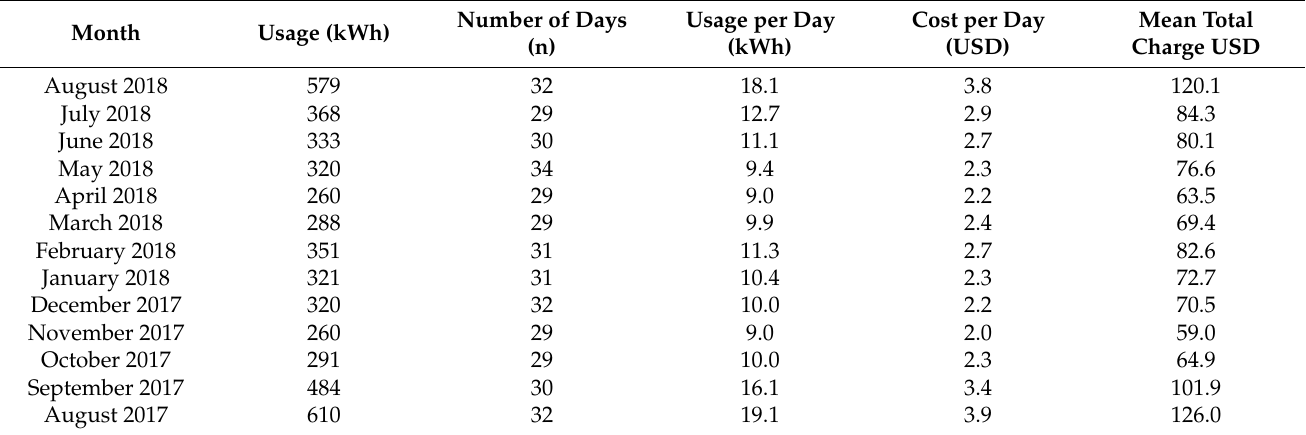
Table 8. Summary of the averages of the monthly electricity usage in the case study